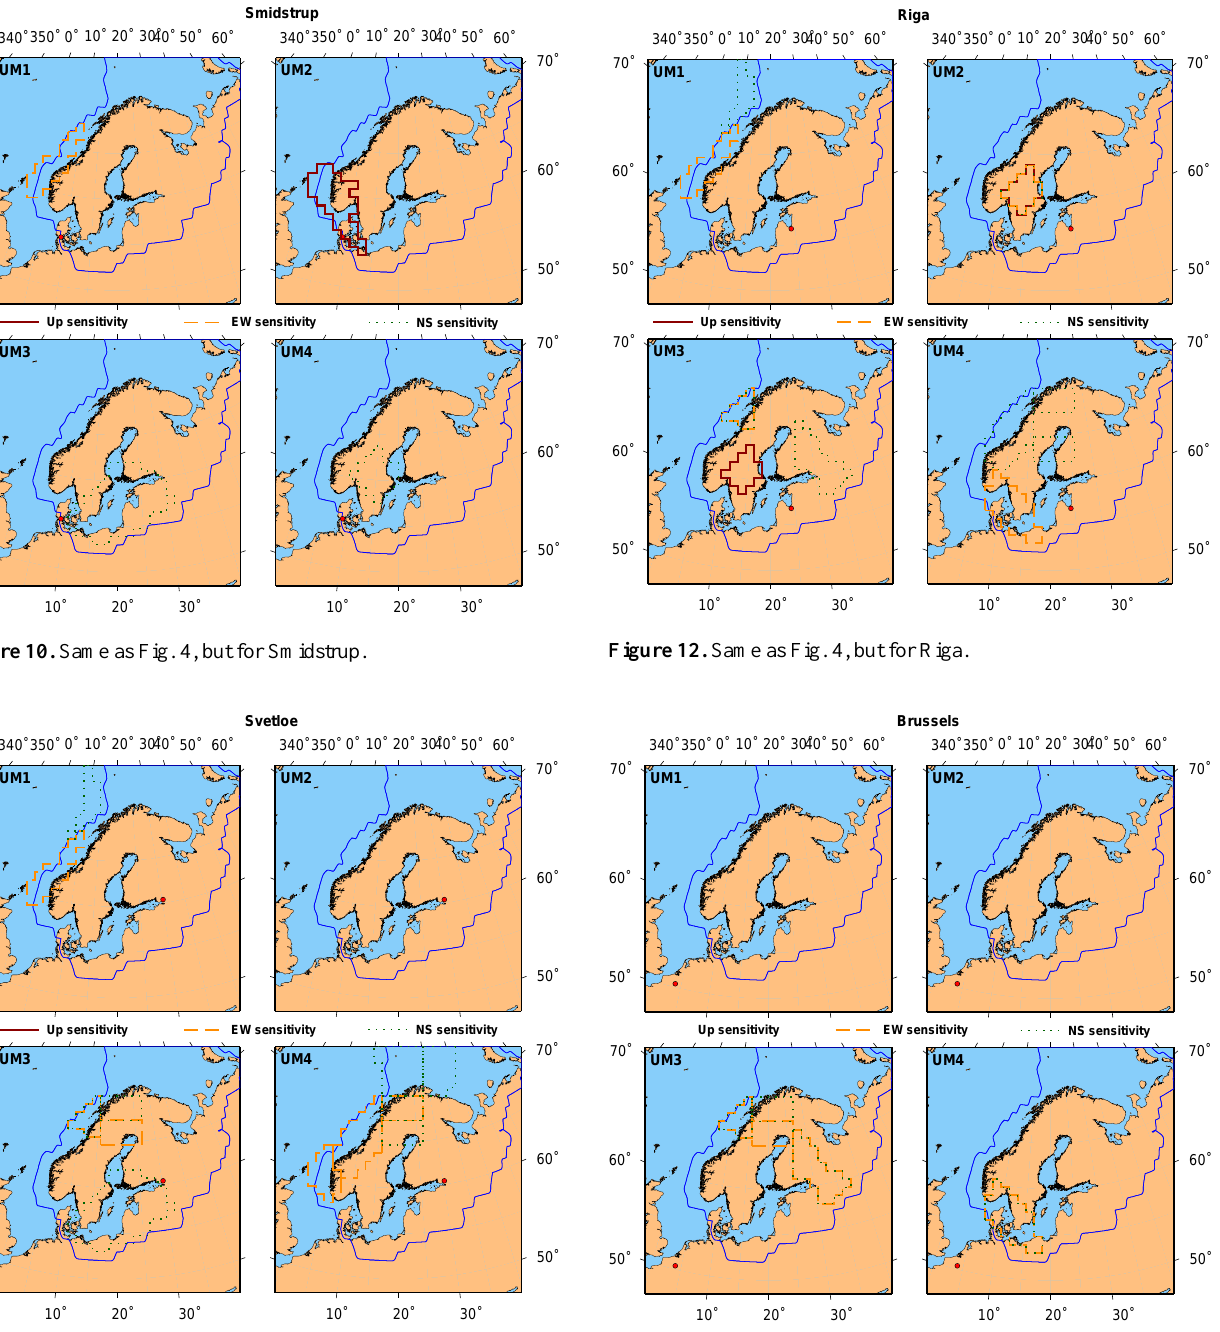
Fig.13. SameasFig.4,butforBrussels. Figure 13. Same as Fig. 4, but for Brussels.